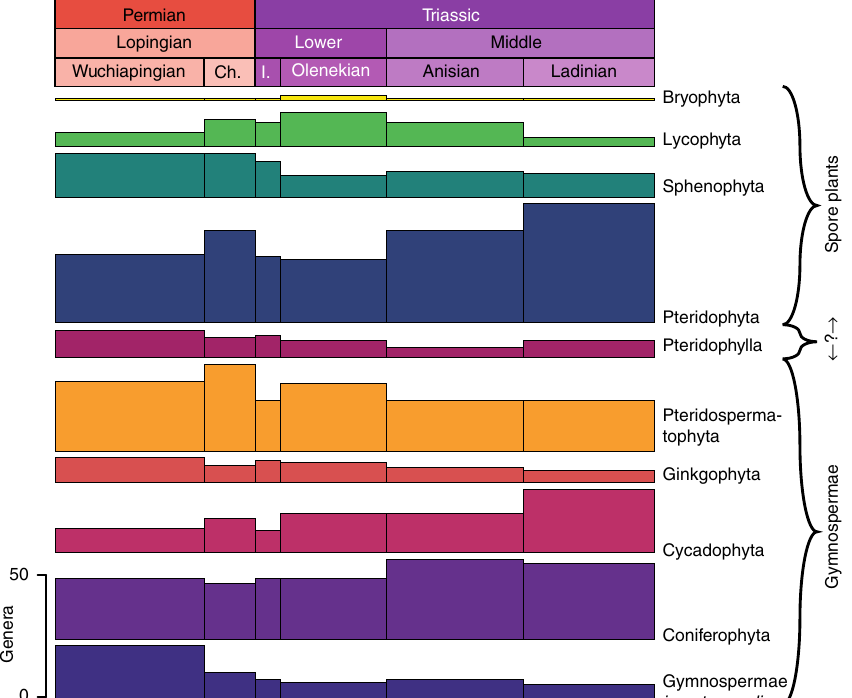
Fig. 6 Sampled-in-bin genus diversities of macrofossils per main plant group. Divisions are grouped as spore-producers and gymnosperms, with Pteridophylla comprising uncertain cases. I. = Induan. Ch. =